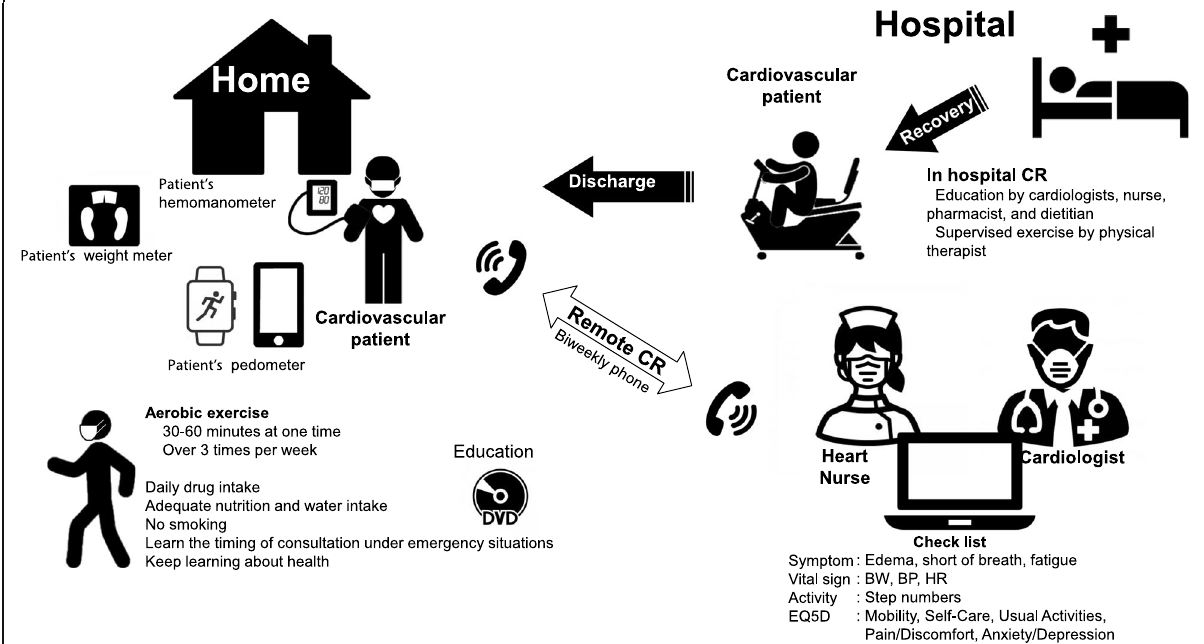
Fig. 1 Schema of remote CR supervised by medical staff. Patients who participated in remote CR were given digital video disk (DVD) guides for home CR created by our CR staff; after discharge, telephone consultation services were provided to them by cardiologists and specialized nurses, every 2 weeks for 5 months. CR, cardiac rehabilitation; HF, heart failure; BW, body weight; BP, blood pressure; HR, heart